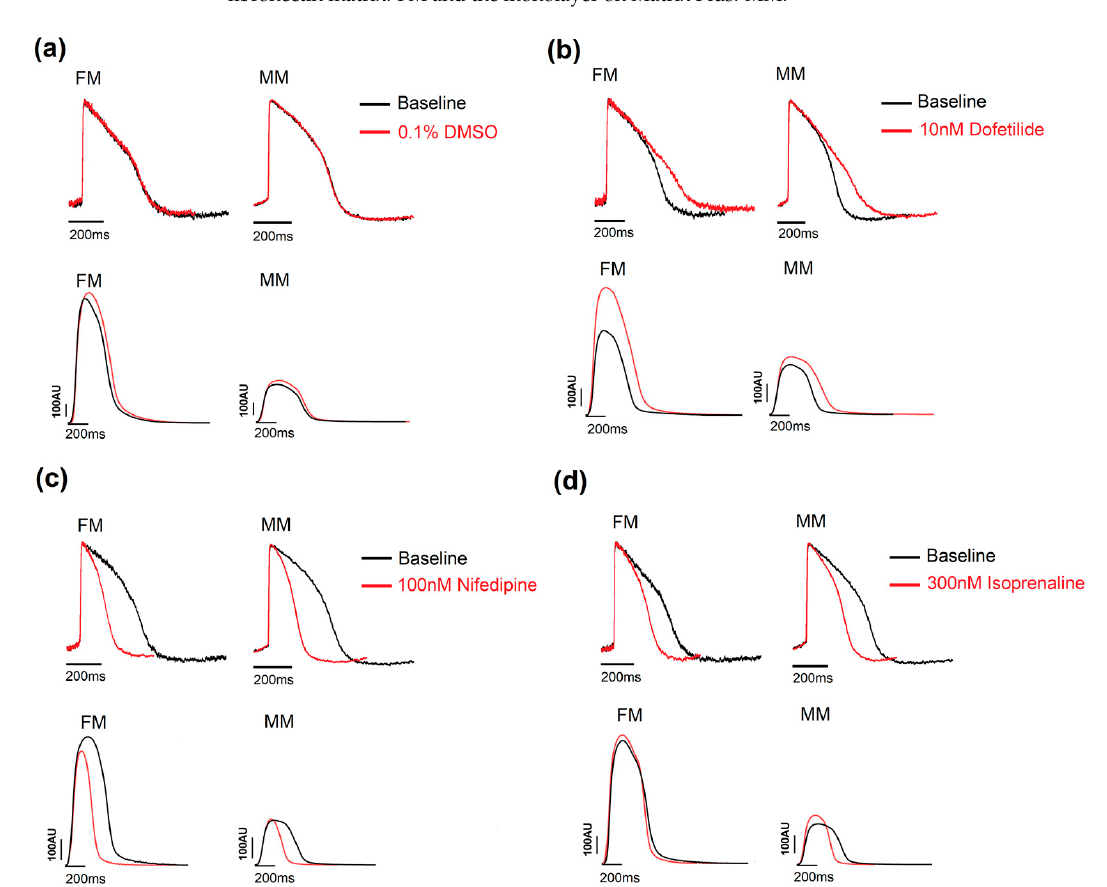
Figure 3. Example traces showing the effect of the three positive controls. ( a ) DMSO 0.1% was used as a vehicle control and had no effect on the traces in the voltage and contractility experiments. ( b ) Dofetilide, a hERG blocker, prolonged the APD in all three models in the two assays. ( c ) Nifedipine reduced the APD 90 and contraction duration for the 2D models. ( d ) Isoprenaline, a β -adrenergic receptor agonist, increased the beat rate and shortened the duration of the traces in both the 2D models. Monolayer in fibronectin (FM) or in Matrix Plus coated plates (MM).